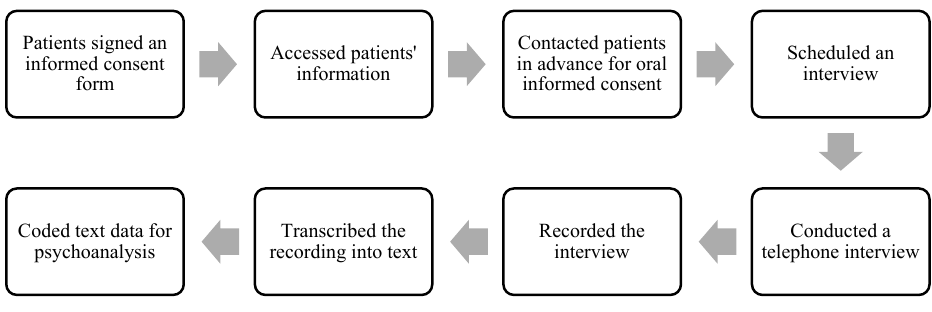
Figure 1. The procedure of the interview.